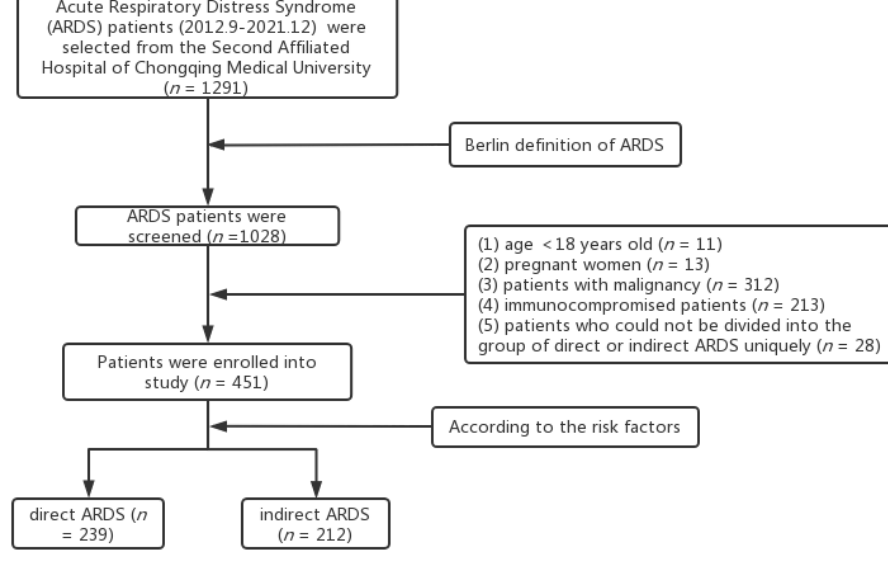
Figure 1. Flow Figure 1. Flow chart.